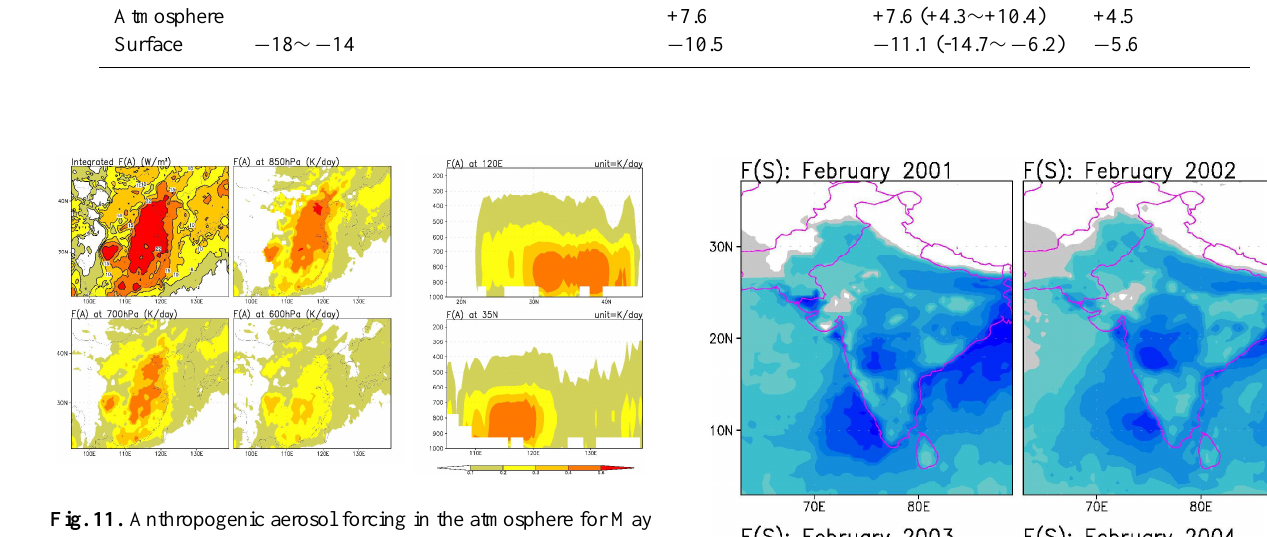
Figure 11. Anthropogenic aerosol forcing in the atmosphere for May (averaged from 2001 to 2004).